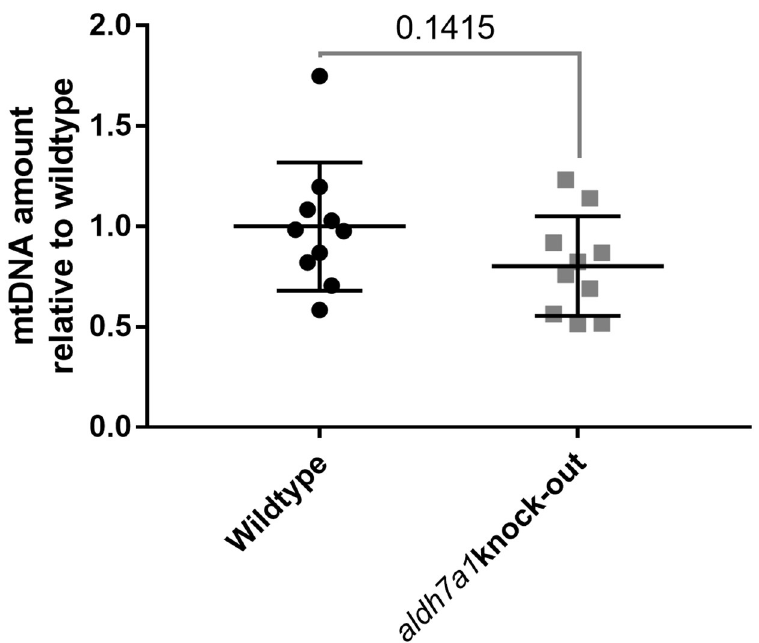
Fig 6. mtDNA amount is not significantly reduced in aldh7a1 knock-out zebrafish. qPCR graph of mtDNA amount from wildtype (Wildtype, black circles) and aldh7a1 homozygous knock-out (aldh7a1 knock-out, grey squares) zebrafish embryos, demonstrating only a slight reduction in mtDNA copy number in knock-out relative to the wildtype embryos. Each dot represents DNA extracted from 5 embryos. The amounts of mtDNA from knock-out and wildtype embryos were normalized to the average mtDNA amount from the wildtype embryos. p value is calculated by an unpaired two-tailed student t-test. Error bars, mean and